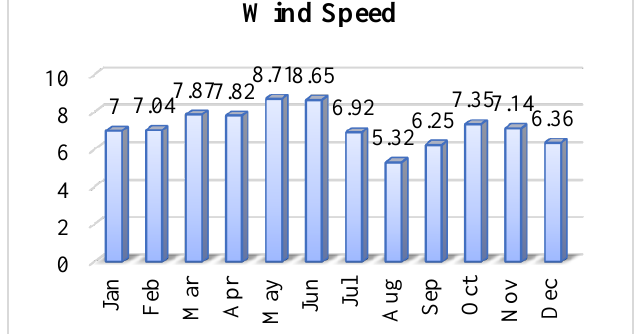
Fig. 3. Monthly average wind speed [27]